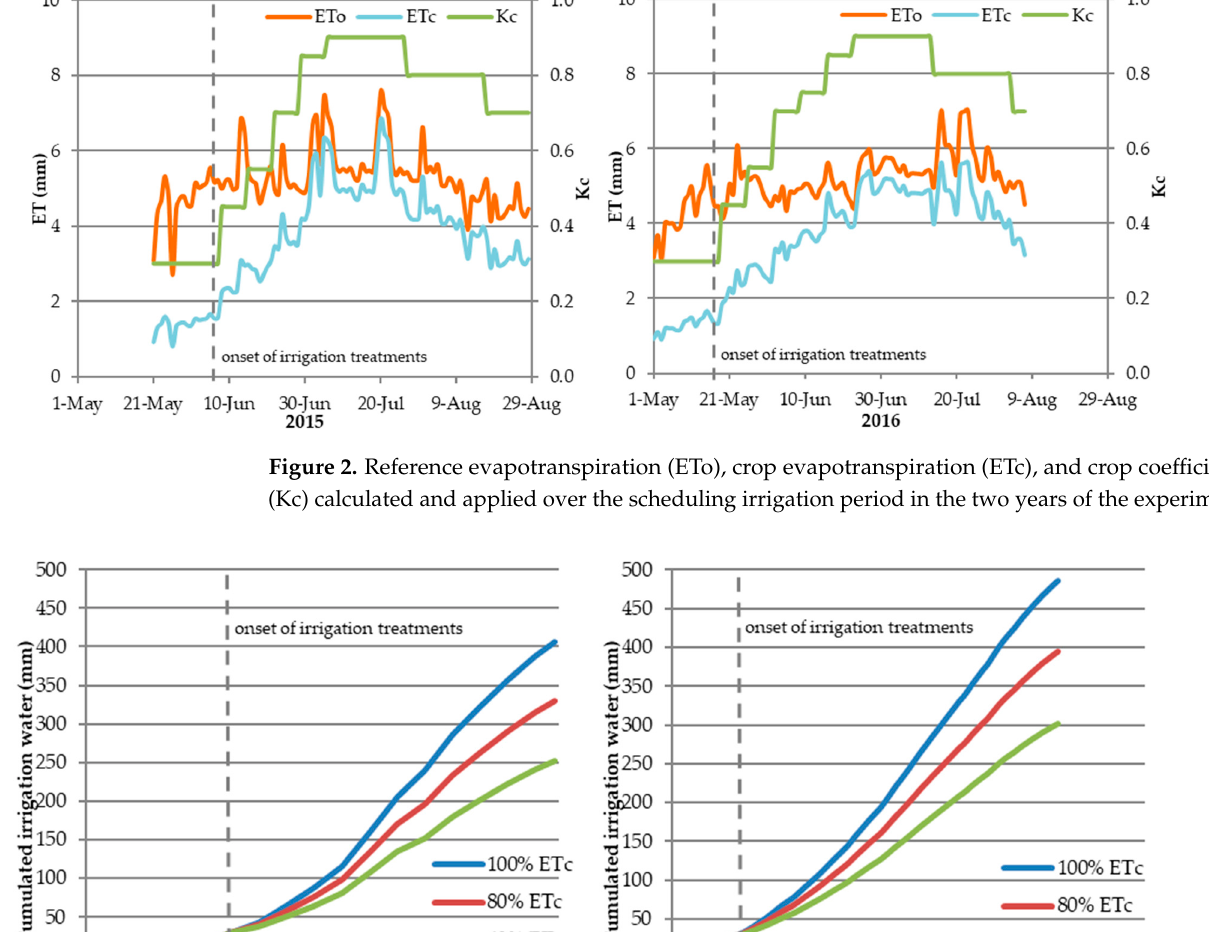
Figure 3. Cumulated amount of irrigation water applied over the scheduling irrigation period in the two years of the experiment.